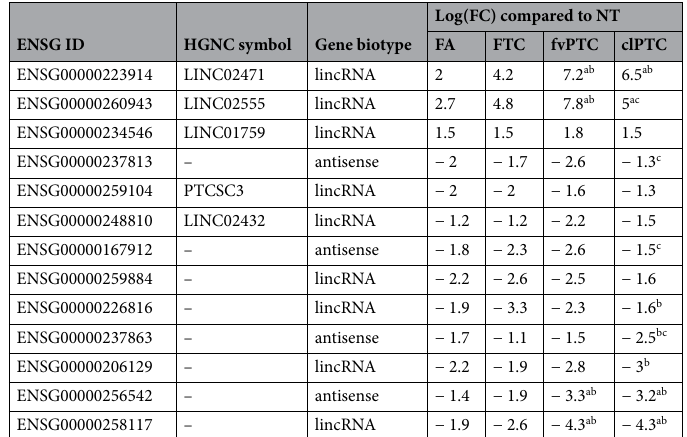
Table 2. LncRNAs common for FA and WDTC. Differential expression of all genes is validated in clPTC and fvPTC. a Significantly differentially expressed compared to FA; b significantly differentially expressed compared to FTC; c significantly differentially expressed compared to fvPTC.